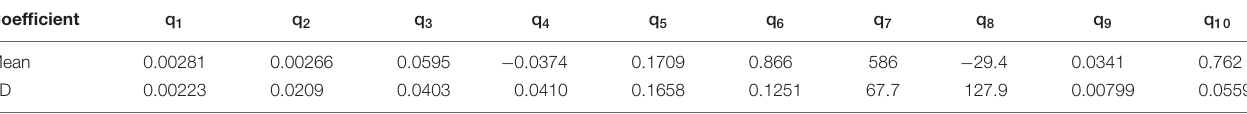
TABLE 1 | Regression coefficients of the gross efficiency relationships derived from submaximal steady state exercise (Equations 4 and 5). Coefficient q